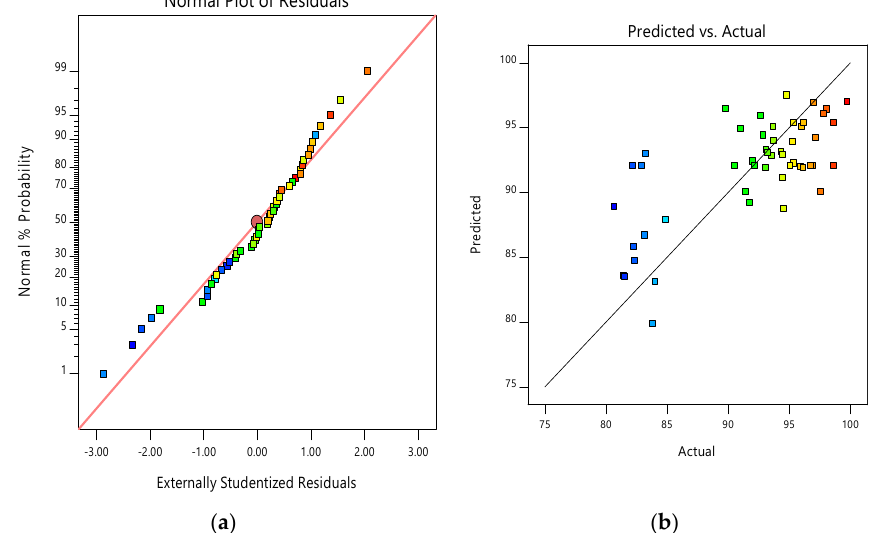
Figure 6. Design-expert plots of ( a ) normal probability curve of the residuals and ( b ) relationship between actual values and predicted values for CIP removal.